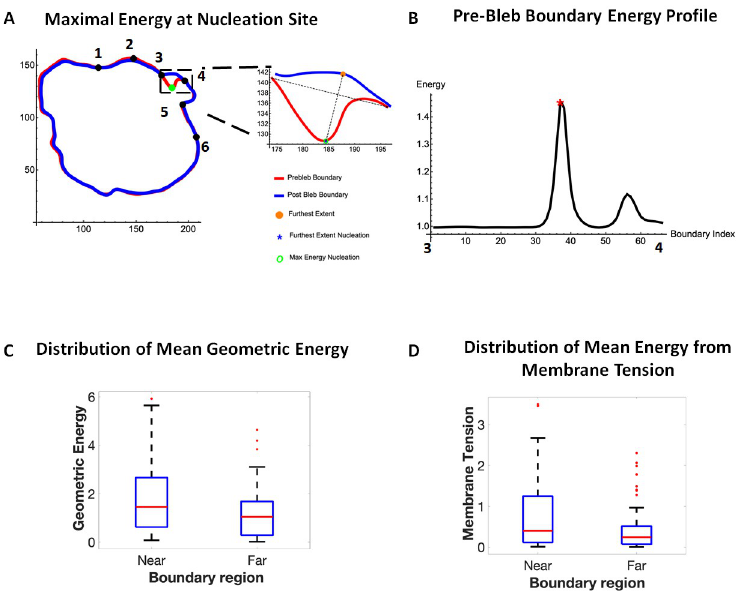
Fig 3. Nucleation sites predominantly form in locations of maximum energy. A) Pre-bleb and Post-bleb boundaries of a cell showing the bleb shoulder points and regions near the bleb (2–3,4-5), far from the bleb (1–2,5-6). An enlarged image of the bleb shows the furthest extent nucleation site at the location of maximal energy. B) The energy profile along the pre-bleb neck (3–4) showing the furthest extent nucleation site (red asterisk) having maximum energy. C). Distribution of mean geometric energy (bending and tension) near the bleb and far from the bleb. Difference in median is significant (Kruskal-Wallis test, p-value = 0.012). D) Distribution of energy from membrane tension near the bleb and far from the bleb. Data is taken from 28 blebs and 9 cells. Difference in median is significant (Kruskal-Wallis test, p-value =